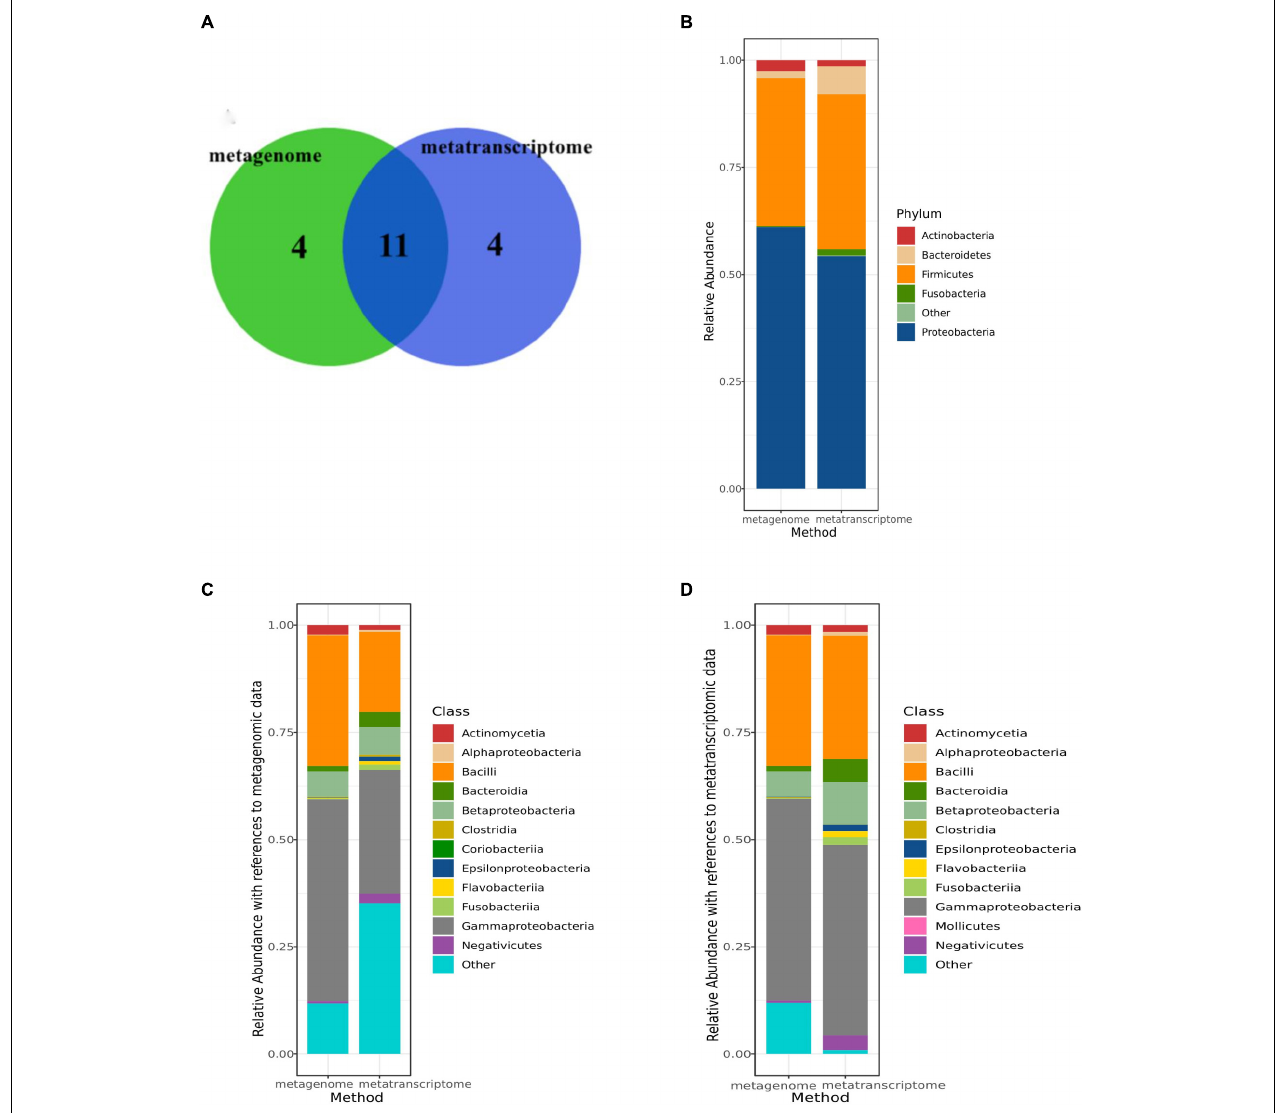
FIGURE 2 | Comparison of microbiome composition between metatranscriptomic data and metagenomic data. (A) Overlap of identified genera between two data sets for the 12 AECOPD patients and 4 stable COPD patient (metatranscriptomic data and metagenomic data). (B) The read abundance of the top 5 most abundant phylum in two data sets (metatranscriptomic data and metagenomic data). (C) The read abundance of the top 12 most abundant classes in metagenomic data in two data sets (metatranscriptomic data and metagenomic data). (D) The read abundance of the top 12 most abundant classes in metatranscriptomic data in two data sets (metatranscriptomic data and metagenomic